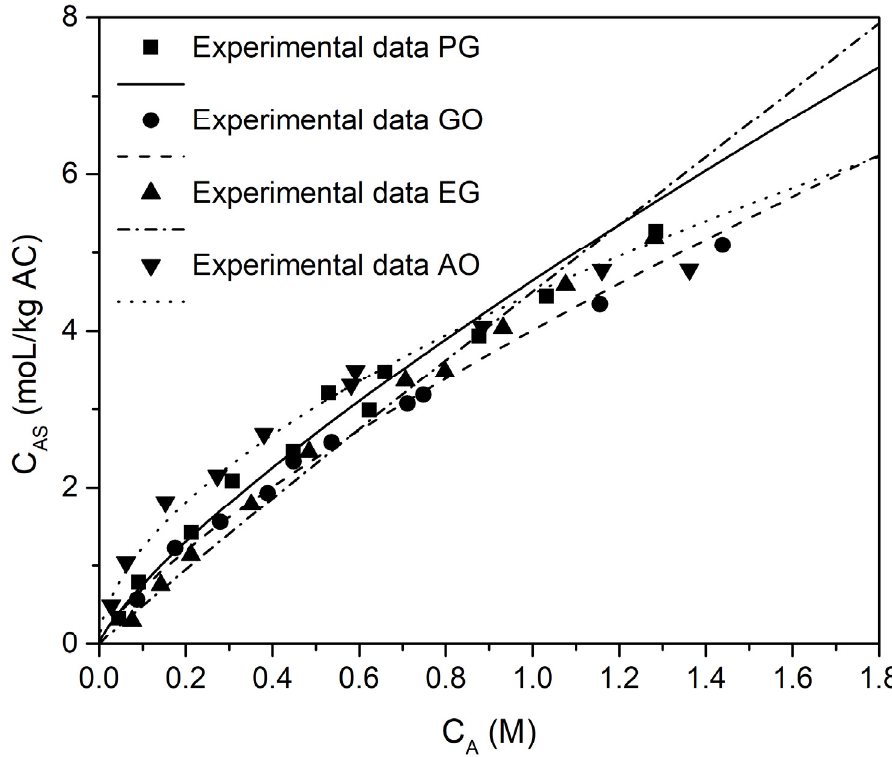
Figure 3. Experimental adsorption data and the fitting to Freundlich isotherms for all four com-